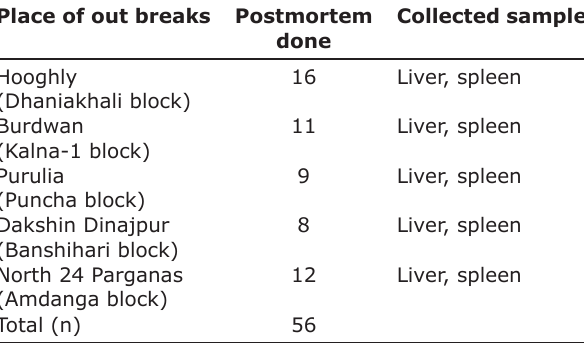
Table-1: Details of sample collection from field outbreaks in West Bengal. Place of out breaks Postmortem done